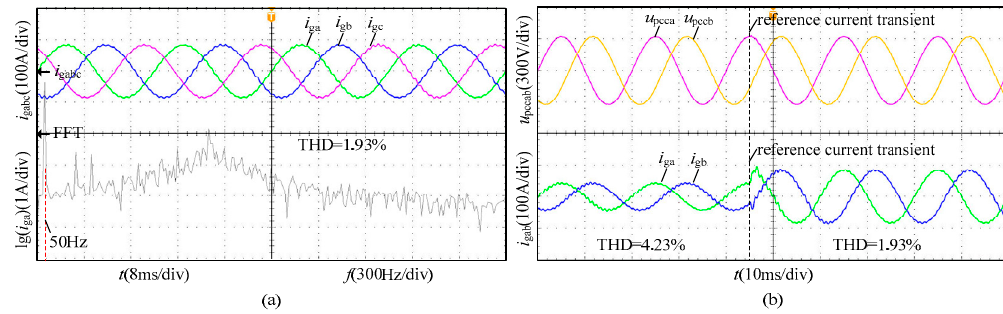
Figure 17. Experimental waveforms of u pcc and i g with proposed admittance reshaping technique 2 within the parameter design range. ( a ) Steady state; ( b ) Transient.